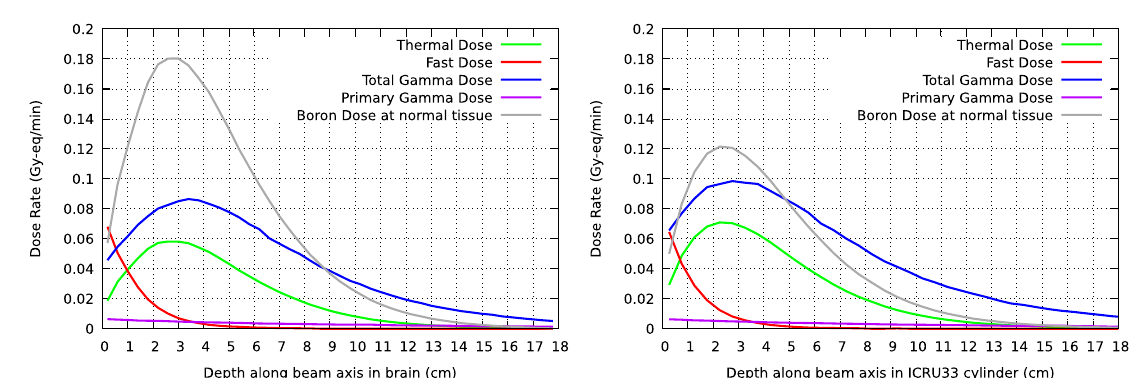
Figure 8. Dose profiles for brain (Snyder head model, left ) and for standard ICRU33 tissue in a cylindrical phantom ( right ). The upper panels show the in-depth dose rate profiles along the beam axis. These panels include the relevant FOMs for each case, namely ADDR, AD, TD, TR and AR. The lower panels show the lateral dose distributions (normalized to the maximum dose in normal tissue) at four depths, namely 1.5, 2.5, 5.0 and 7.5 cm.